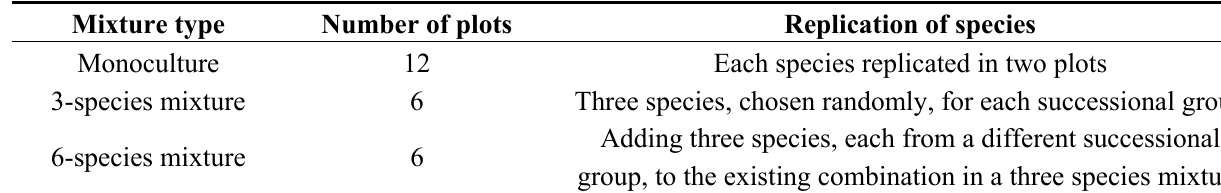
Table 1. Overview of the different types of diversity plots with the number of plots and explanation of species